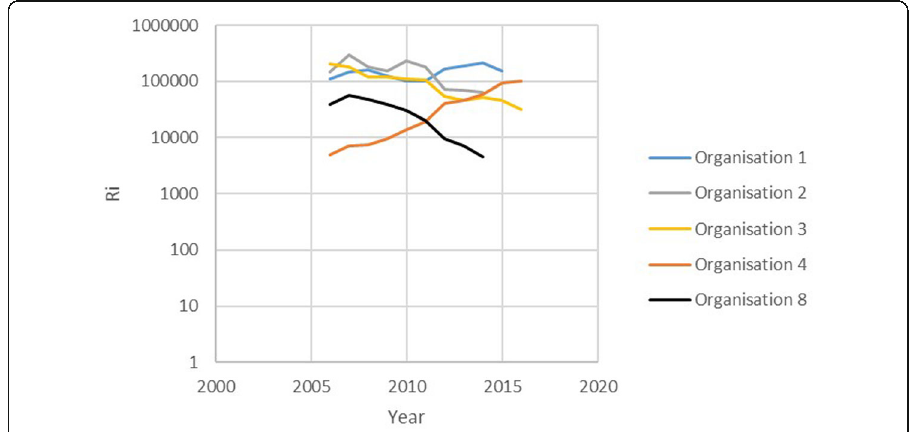
Fig. 16 R i performance of the top innovation organisations and the 8th place